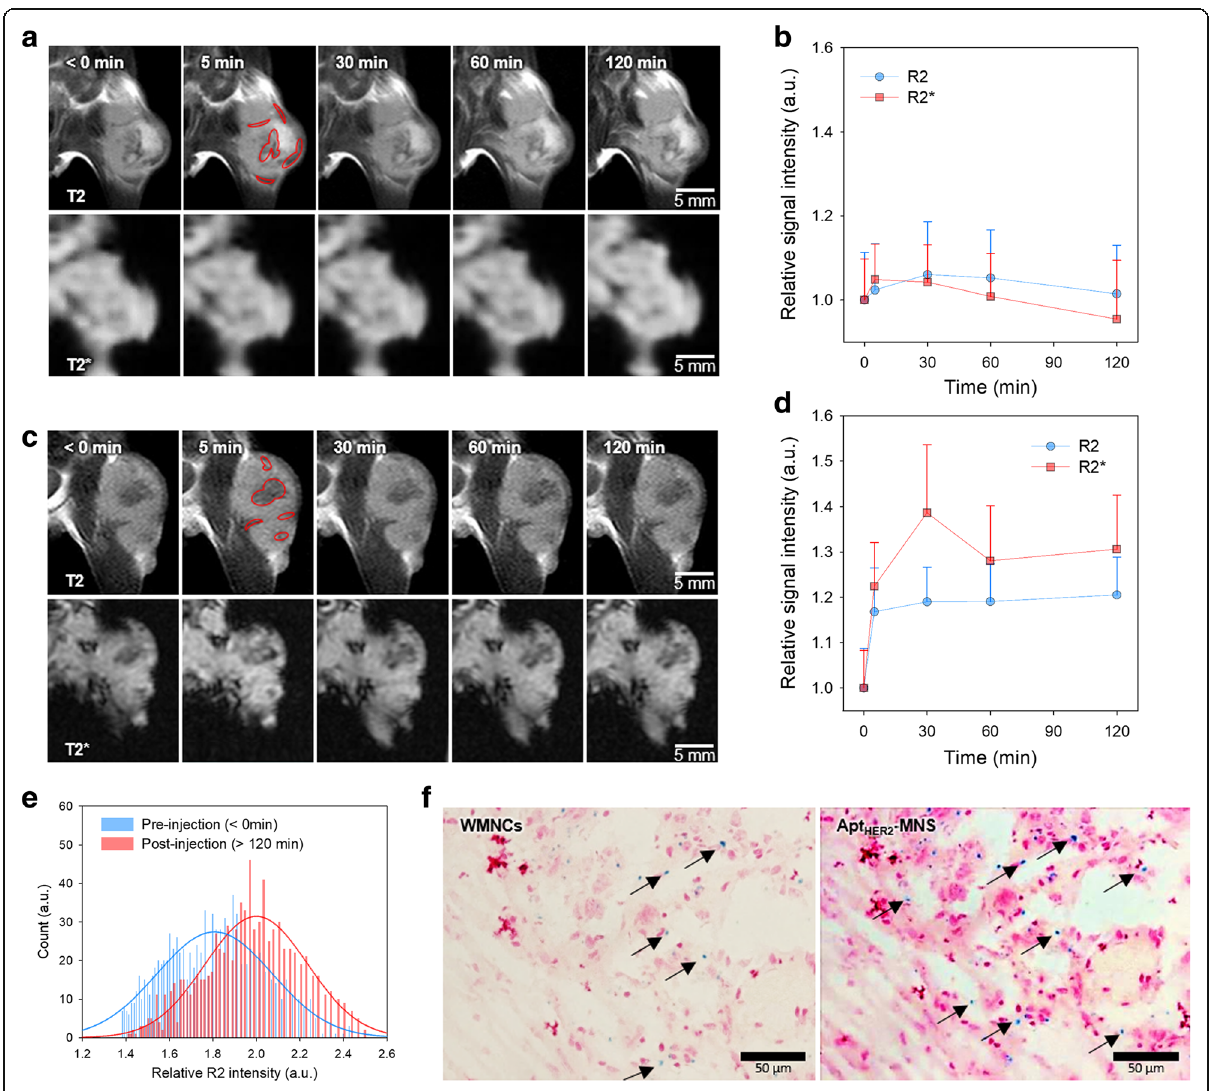
Fig. 5 In vivo MR images of HER2+ tumor mouse model using WMNCs ( n = 3) or Apt HER2 -MNS ( n = 3). a T2- and T2*-weighted MR images at the pre- or post-injection of WMNCs. b Relative signal intensity graph measured from a . c T2- and T2*-weighted MR images at the pre- or post- injection of Apt HER2 -MNS. d Relative signal intensity graph and e the intensity histogram of tumor region measured from c . f Histological analysis data obtained after MR imaging. Error bars were represented by positive y -axis only. Relative signal intensities of b , d , and e were measured from the red solid-lined ROI of a , c , and Additional file 1: Figure